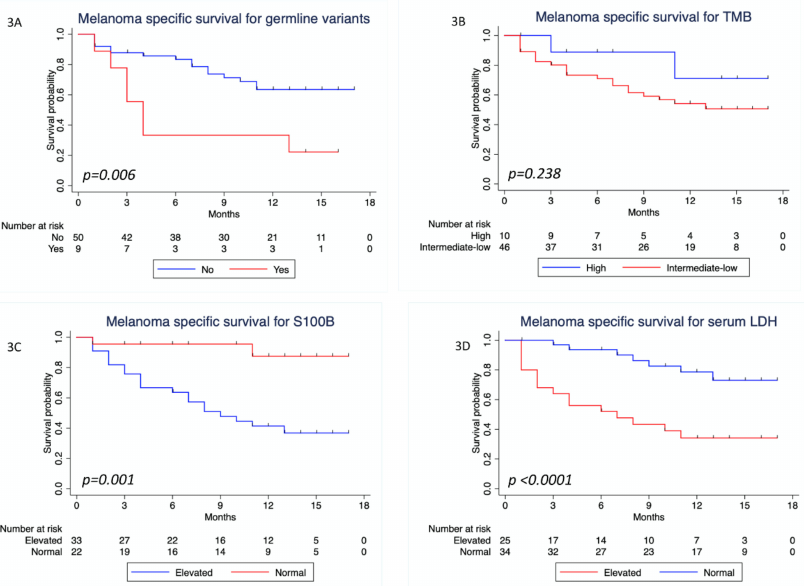
Figure 3. Melanoma specific survival analysis. ( A ) Kaplan–Meier curve for melanoma specific survival, considering the presence of pathogenic and likely pathogenic germline variants (Yes / No); ( B ) Kaplan–Meier curve for melanoma specific survival considering TMB intermediate-low ( ≤ 23.1 mut / Mb) or high ( > 23.1 mut / Mb); ( C ) Kaplan–Meier curve for melanoma specific survival considering serum S100B levels (normal / elevated); ( D ) Kaplan–Meier curve for melanoma specific survival considering serum lactate dehydrogenase (LDH) levels (normal / elevated). p -values refer to two-sided log rank